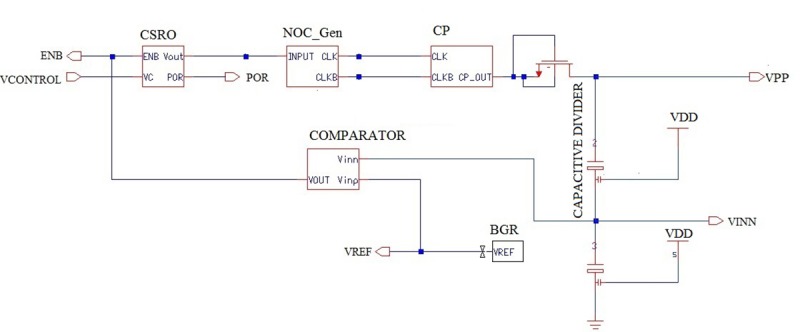
Schematic diagram of the proposed HVG circuit.